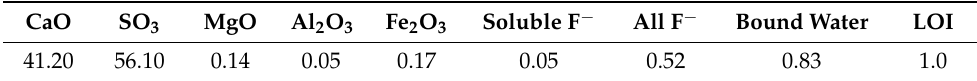
Table 2. Main chemical compositions of FG/wt.%.